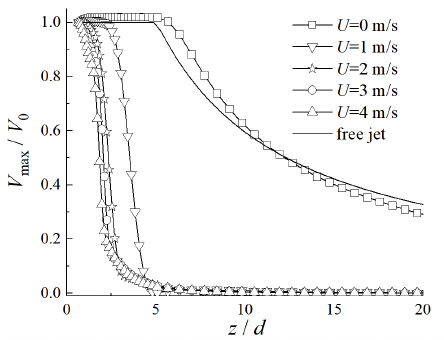
Figure 11. V max / V 0 attenuation of the vertical discharge jet under different U . As seen in Figure 8, without ambient wind, the turbulent jet discharged from the vertical outlet continuously exchanged mass and momentum with the surrounding am- bient air under transverse pulsation, driving the surrounding air flow so that the mass flow and cross-sectional area of the jet continuously increased along the height direction, forming a pyramidal flow field diffusing around. The dimensionless axial velocity V max / V 0 attenuation of the jet was almost consistent with that of the free turbulent jet (Figure 11). With ambient wind (Figures 9 and 10), the polluted gas discharged from the vertical outlet diffused downwind and rose continuously under the combined action of its own kinetic energy through buoyancy effects caused by concentration difference and ambient wind. After a certain distance, it tended to be horizontal. This horizontal and vertical dif- fusion is called tail swinging and lifting of polluted air flow. The higher the ambient wind speed U , the faster the axial velocity attenuation of the jet due to the shear force of the transverse air flow (Figure 11), the greater the transverse diffusion of the polluted air flow in the horizontal direction, and the more significant the tail swing effect. In addition, be- cause of the acceleration of the wind, the buoyancy and longitudinal diffusion of the ex- haust gas were reduced, and the lifting effect of the exhaust gas was inhibited. Therefore, the phenomenon of vertical pollutants discharging at the upper vent can be regarded as free buoyant jet diffusion under the momentum of ambient wind. Moreo- ver, the movement of pollutants in the horizontal direction was mainly affected by the diffusion induced by the concentration difference and the convection caused by ambient wind.